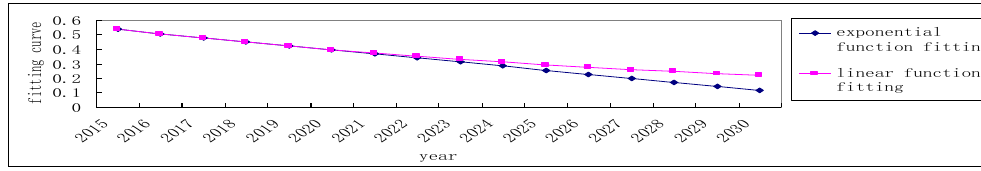
Figure 8. Unit policy subsidy with linear function fitting and exponential function fitting.